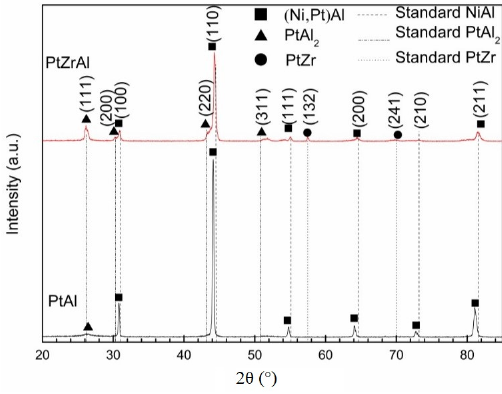
Figure 3. XRD patterns of the Pt coating after aluminization.